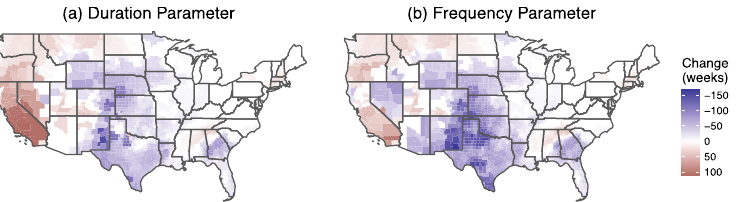
Figure 2. Changes in hazard parameters from the first study period (2010–2014) to the second study period (2015–2019). Negative values show a significant decrease from the first to the second study period. Positive values indicate a significant increase in the second study period.